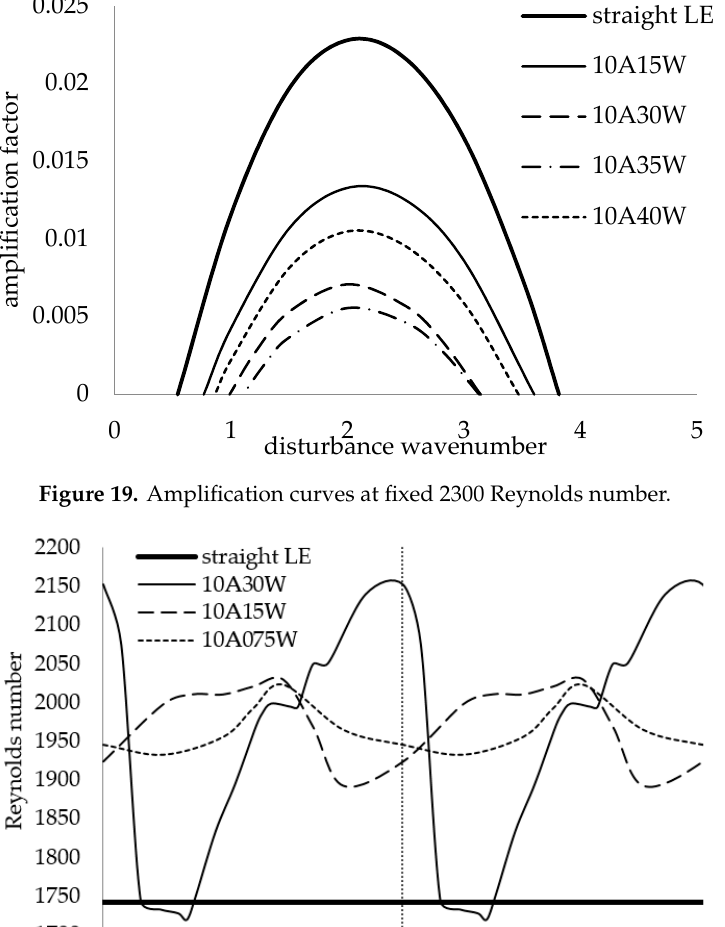
Figure 18. Critical Reynolds numbers for different LE geometries.